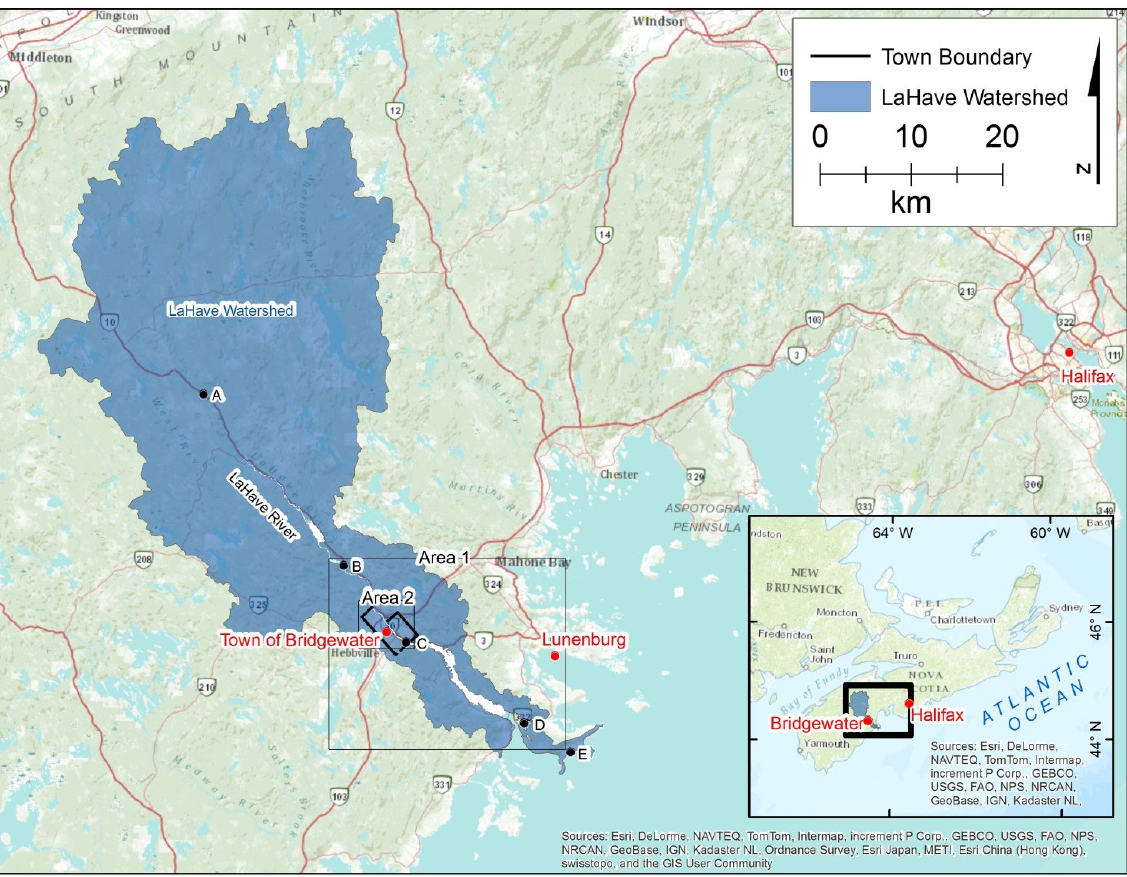
Figure 1. The Town of Bridgewater is an inland coastal community located along the banks of the LaHave River in the southern region of Nova Scotia, Canada. A: AGRG